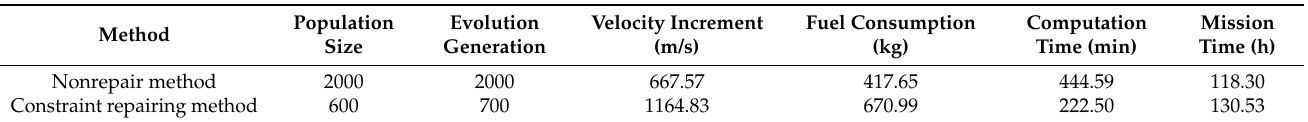
Table 2. Population size, evolutionary generation, velocity increment, fuel consumption, computation time, and mission time for two methods. Method